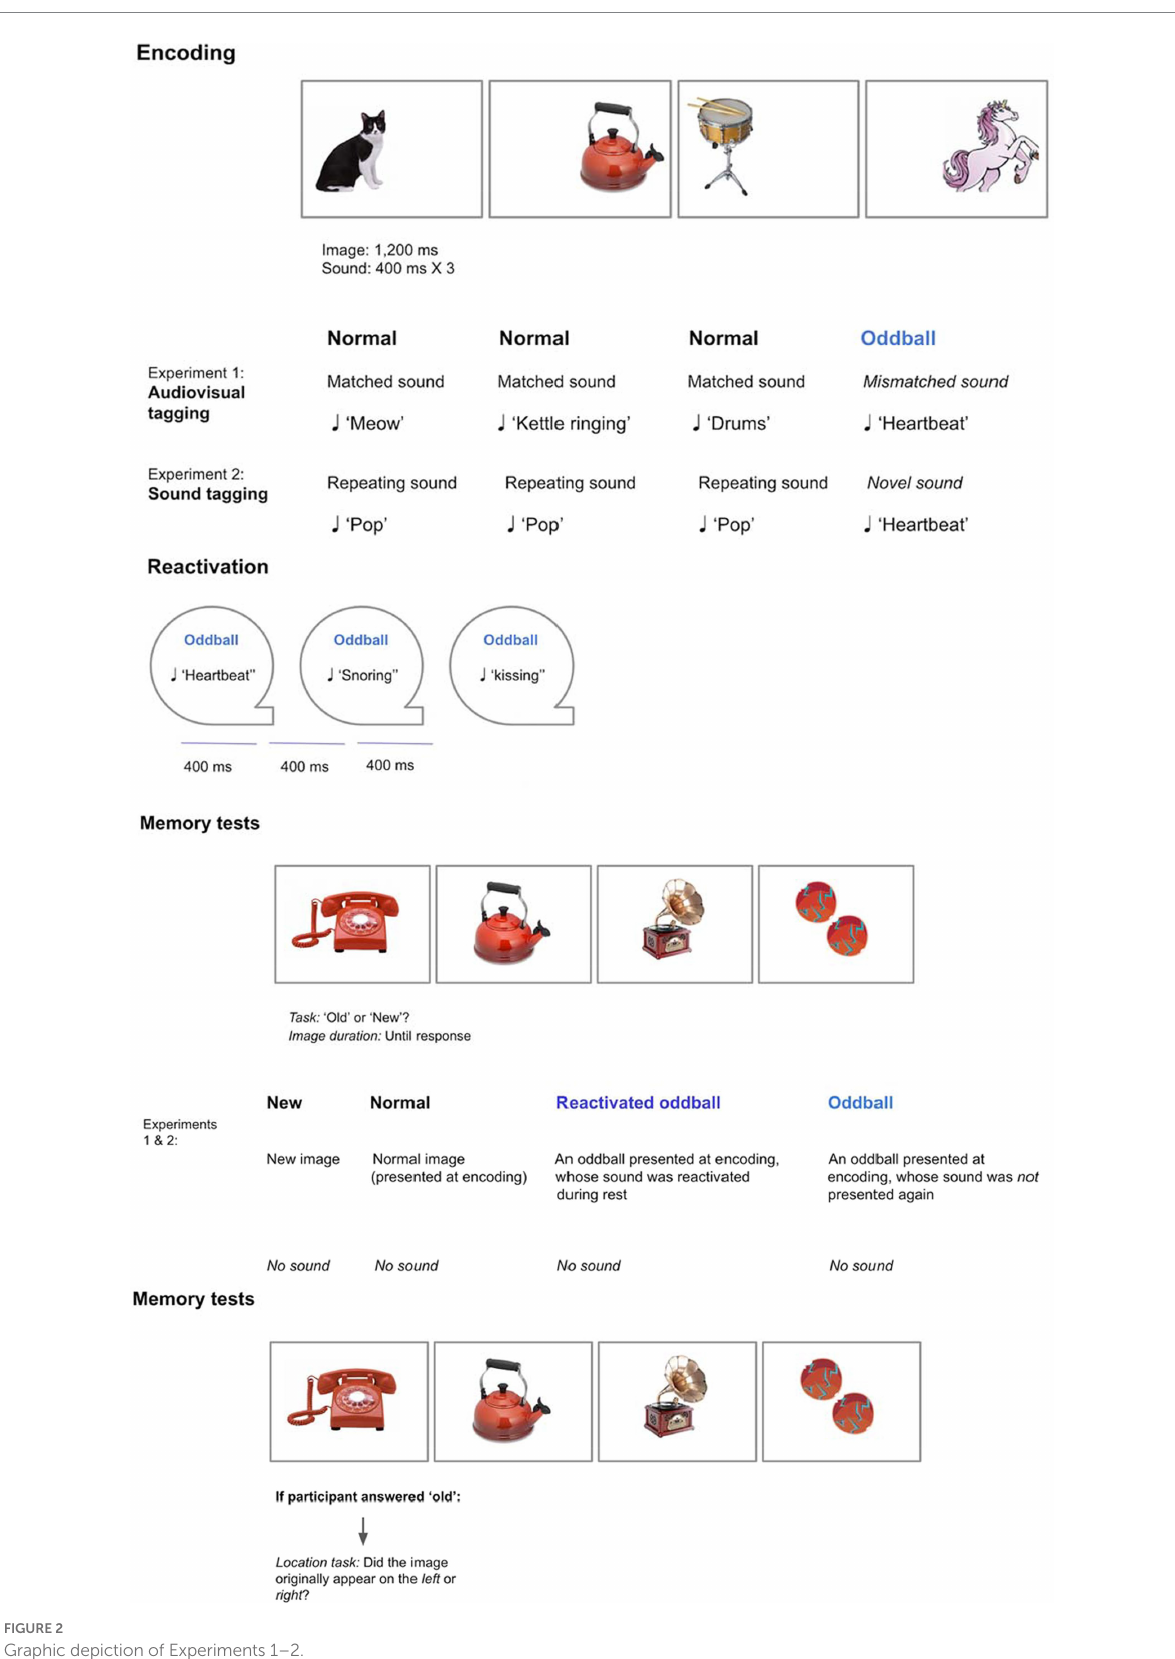
FIGURE 2 Graphic depiction of Experiments